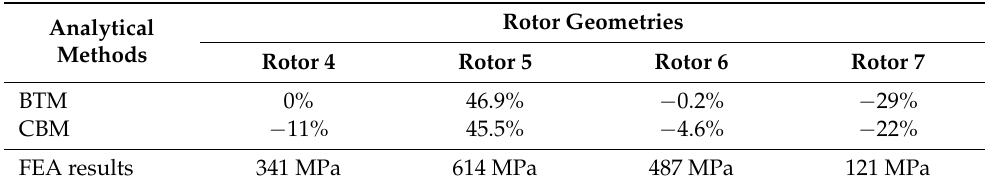
Table 4. Evaluation of the analytical methods to determine maximum mechanical stress at the central